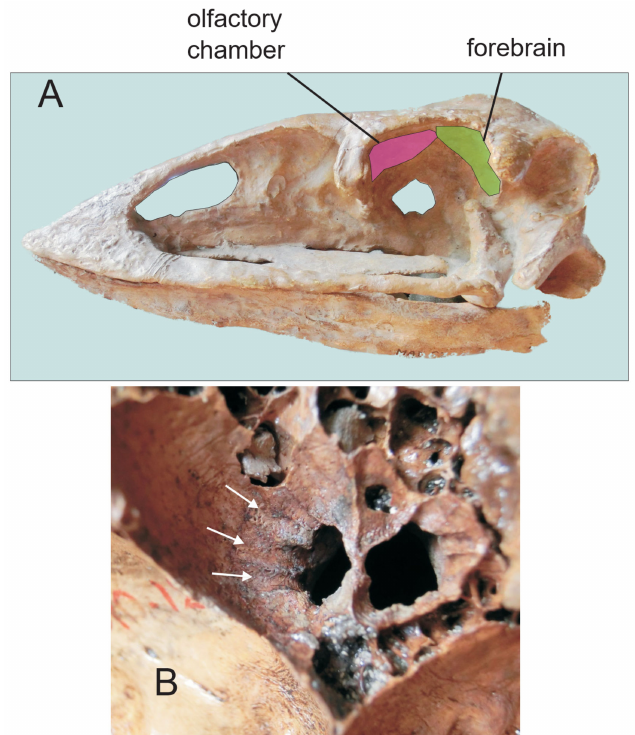
Figure 6. ( A ) Aepyornis ?hildebrandti , MNHN MAD6724 olfactory chamber and forebrain outlined ( B ) Aepyornis maximus MNHN 1910.12, rostral view of olfactory formaina with radiating nerve grooves (arrows).